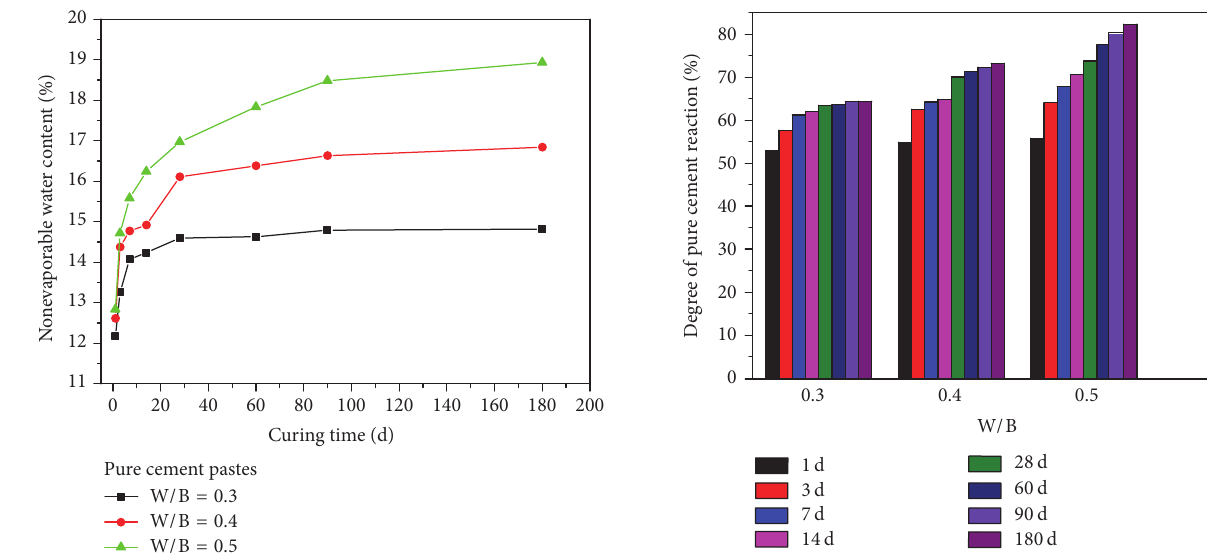
Figure 4: Nonevaporable water content of pure cement pastes. Figure 5: Nonevaporable water content of pure cement